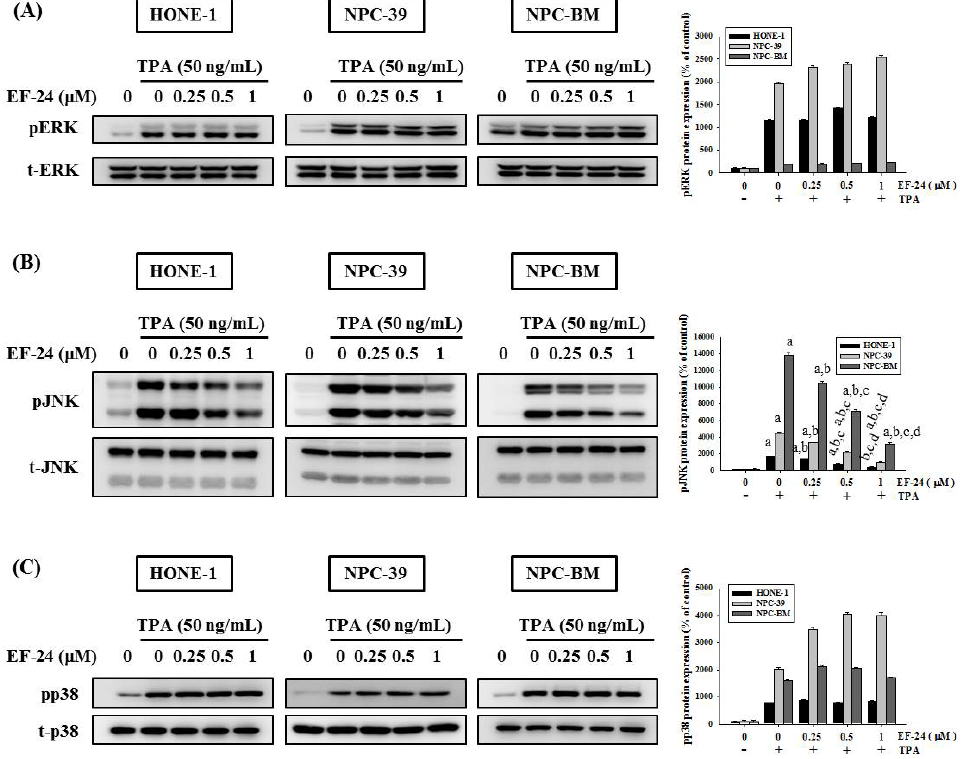
Figure 5. Regulation of EF-24 on MAPK activation. NPC cell lines were pretreated with EF-24 for 1 h and subsequently incubated with TPA for 23 h. Protein lysate was collected for a Western blot analysis to evaluate the phosphorylation of ERK ( A ), JNK ( B ), and p38 MAPK signaling ( C ). Densitometric data of kinase phosphorylation were obtained by ImageJ. Images shown are representative of three separate experiments. a Significantly different, p < 0.05, when compared with the control group. b Significantly different, p < 0.05, when compared with the TPA treatment group. c Significantly different, p < 0.05, when compared with the TPA treatment plus EF-24 (0.25 μM) group. d Significantly different, p < 0.05, when compared with the TPA treatment plus EF-24 (0.5 μM) group.